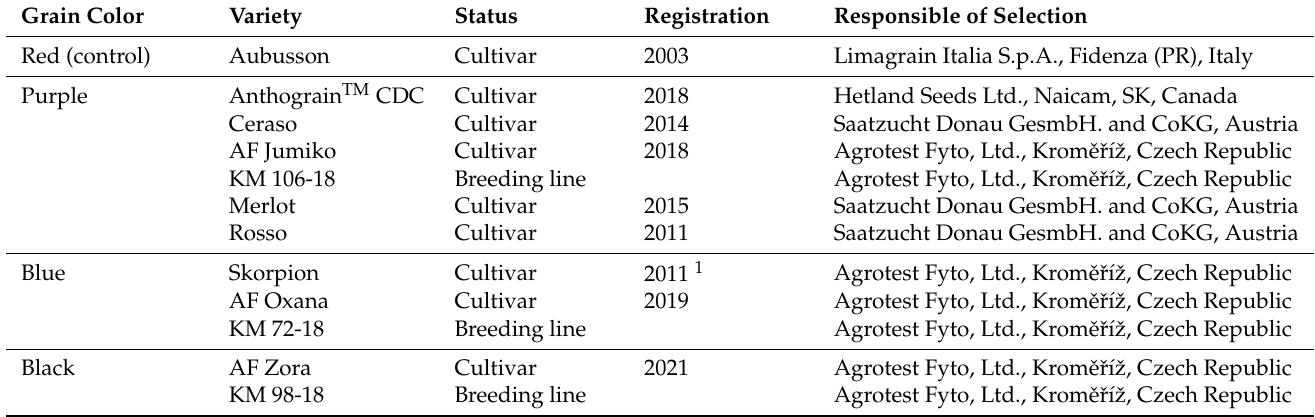
Table 4. Pigmented wheat varieties compared in the two growing seasons field